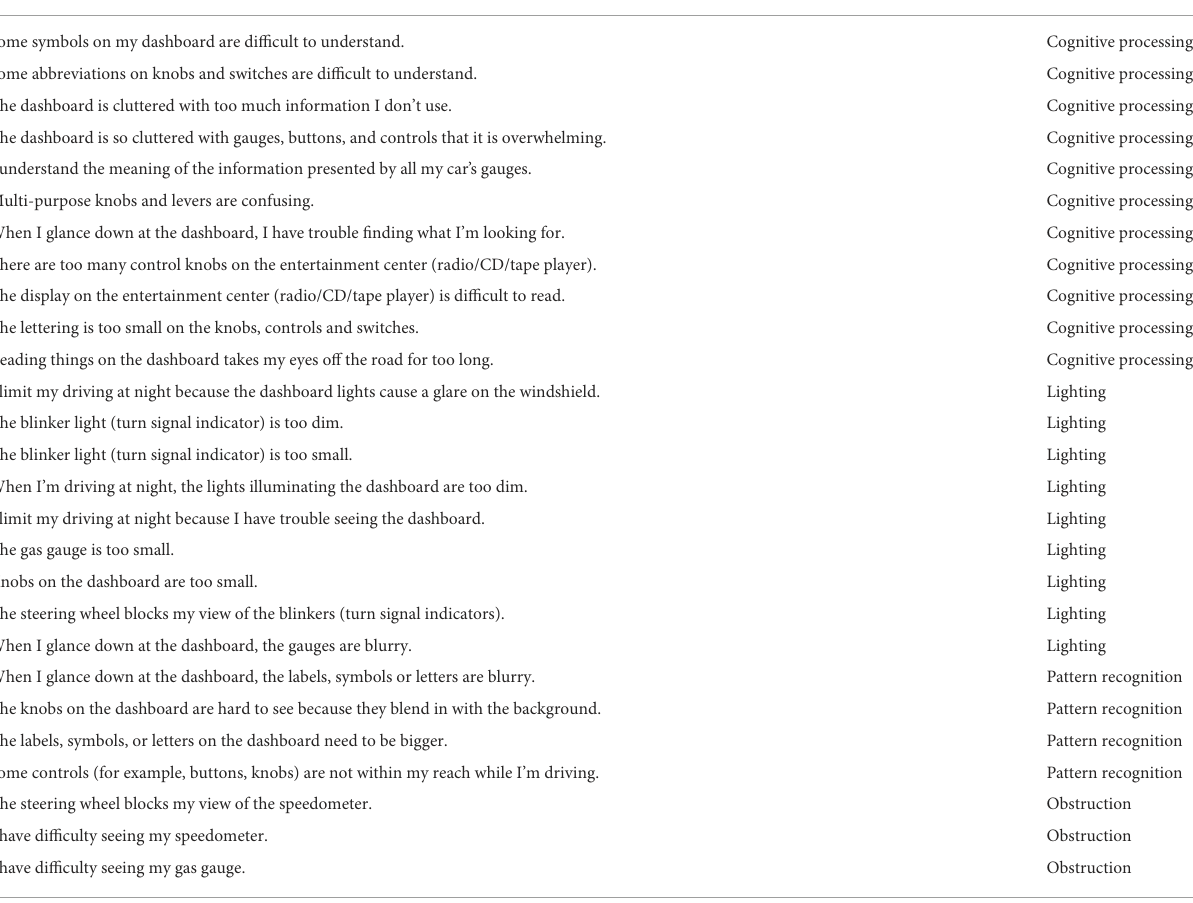
TABLE 1 Dashboard questionnaire items evaluated and corresponding domain derived from Rasch analysis. Questionnaire